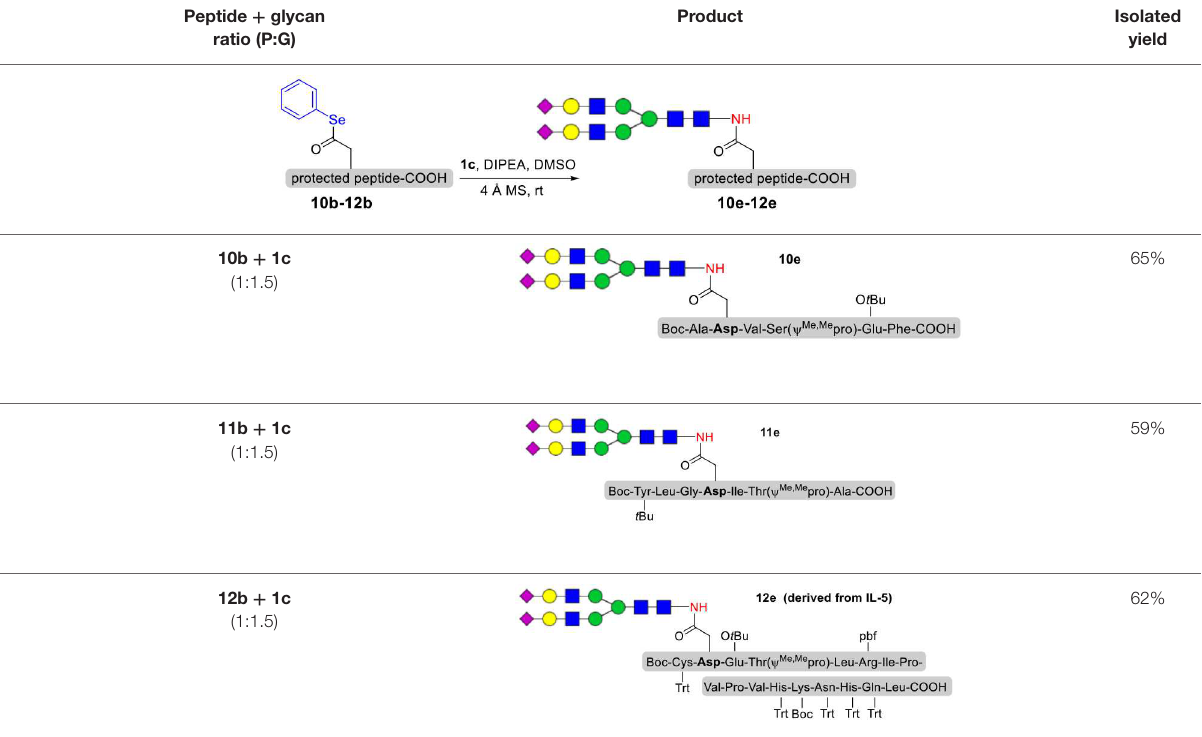
TABLE 5 | Selenoester-mediated glycosylation a . Entry Peptide + glycan ratio (P:G)